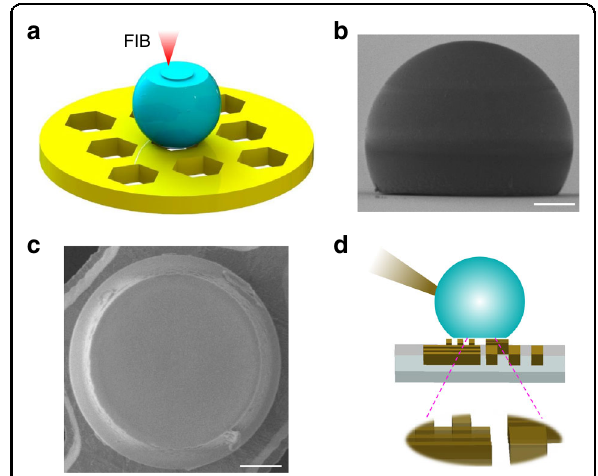
Fig. 2 The fabrication and characterization of HHMSs. a Schematic of fabricating HHMS by FIB milling. Side view ( b ) and bottom view ( c ) of an HHMS fabricated by FIB. Scale bars: 5 μ m. d Schematic of